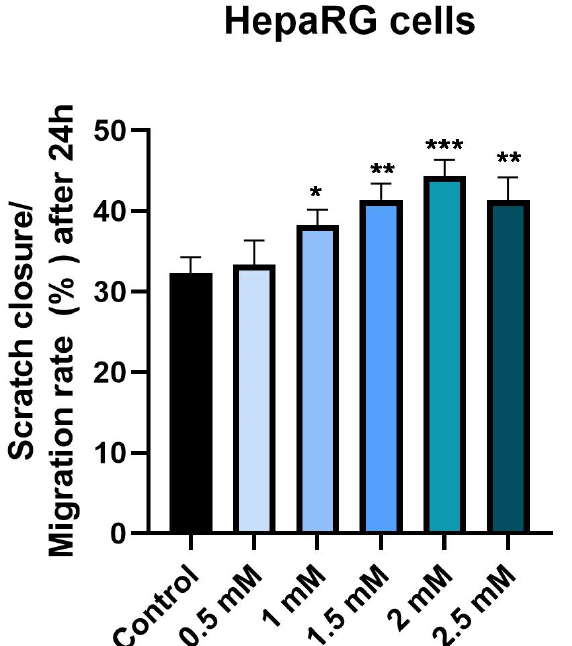
Figure 7. Scratch closure rate of HepaRG following Met treatment (0.5, 1, 1.5, 2 and 2.5 mM). The bar graphs are presented as wound closure percentage after 24 h compared to the initial surface. The data are expressed as mean values ± SD of three independent experiments performed in triplicate. The statistical differences between the Control and the Met-treated group were identified by applying the one-way ANOVA analysis followed by the Dunnett’s multiple comparisons post-test (* p < 0.05; ** p < 0.01; *** p <